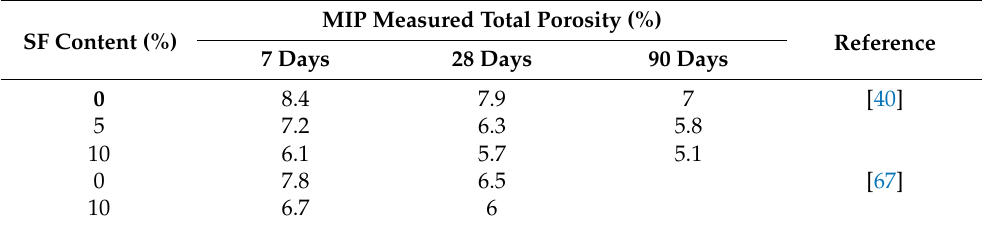
Table 7. Porosity of concrete made with different contents of SF as partial cement